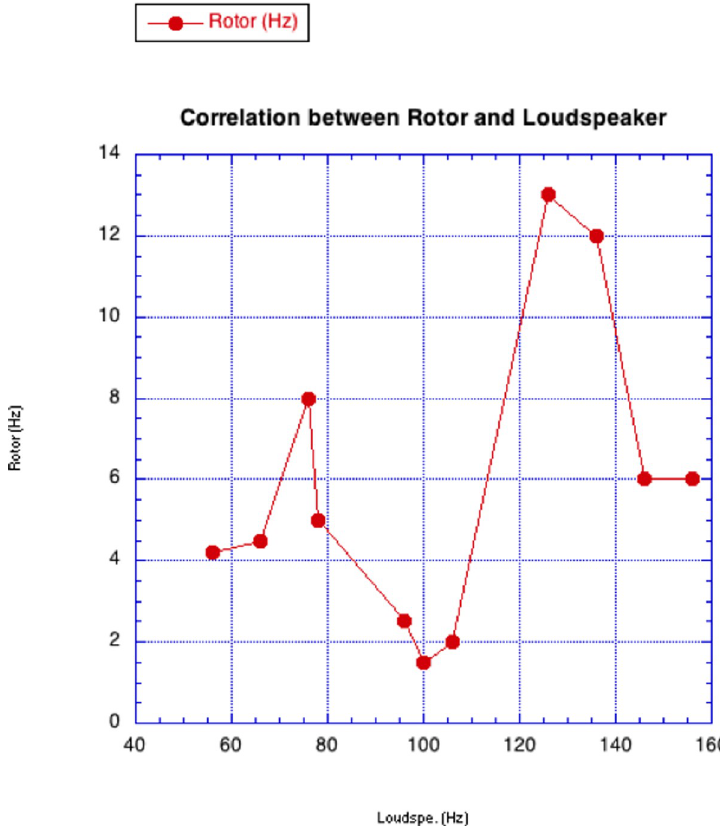
Fig 5. Experimental results for the loudspeaker vibration source. Rotor frequency vs. loudspeaker frequency for a notched stick mounted on a loudspeaker and with a free moving microbearing.